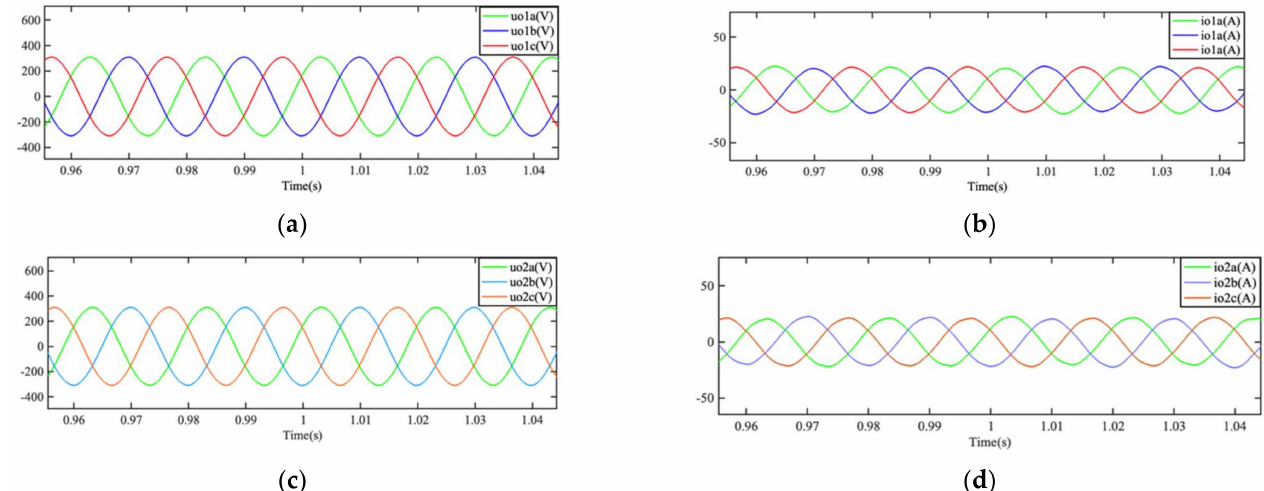
Figure 9. Simulation results in operating mode 1. ( a ) The output voltages of inverter 1; ( b ) The output currents of inverter 1; ( c ) The output voltages of inverter 2; ( d ) The output currents of inverter 2.